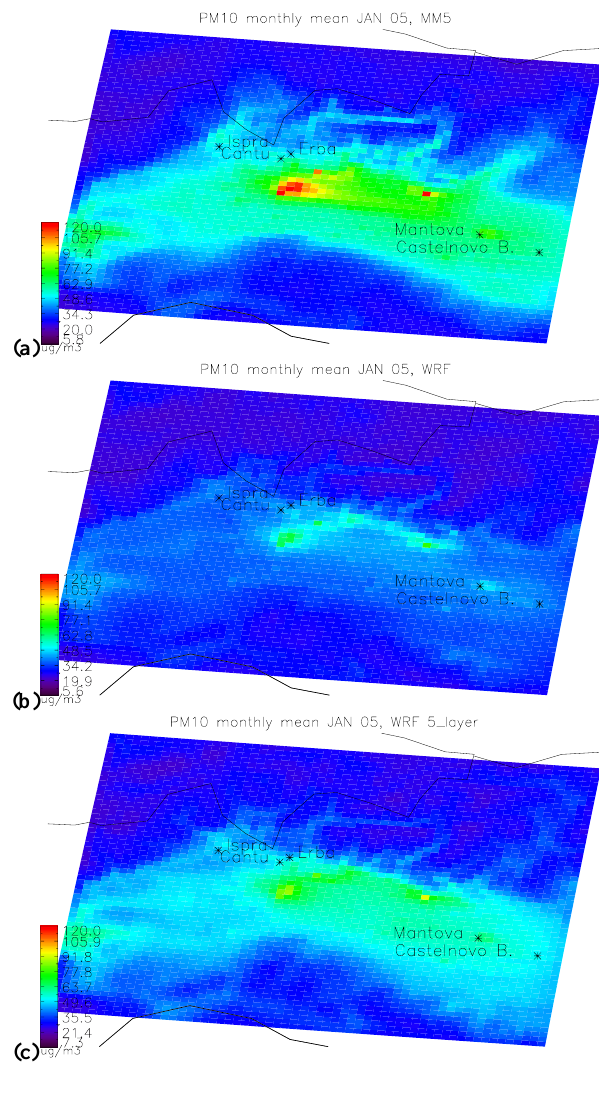
Fig. 4. Monthly mean PM 10 concentrations for January by CHIMERE using the MM5 meteorology (a) , WRF meteorology (b) and WRF meteorology using the 5-layer soil temperature model + MRF PBL scheme (c)